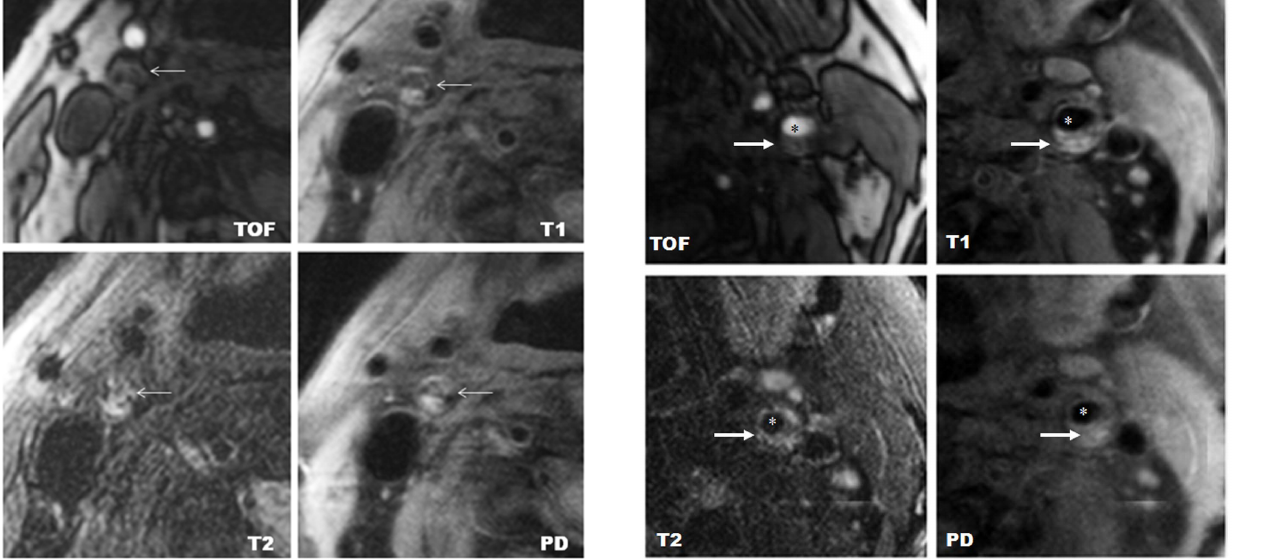
Figure 1. Example of lesion type IV–V in the right internal carotid artery. Lesion type IV–V is characterized by a lipid-rich necrotic core; ( r ) indicates carotid plaque. The lipid-rich necrotic core shows low- to iso-signal intensity on TOF, T1w, PDw, and T2w images.